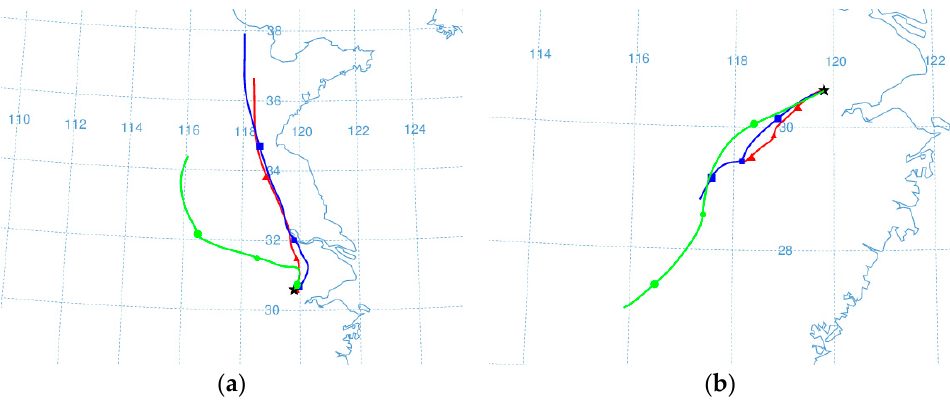
Figure 7. Moisture transport pathways to Hemuqiao basin for two plum rain events. The three colorful lines in the air trajectory figure represent three different pathways of moisture sources. Figure ( a , b ) represents Event 5 and 6.